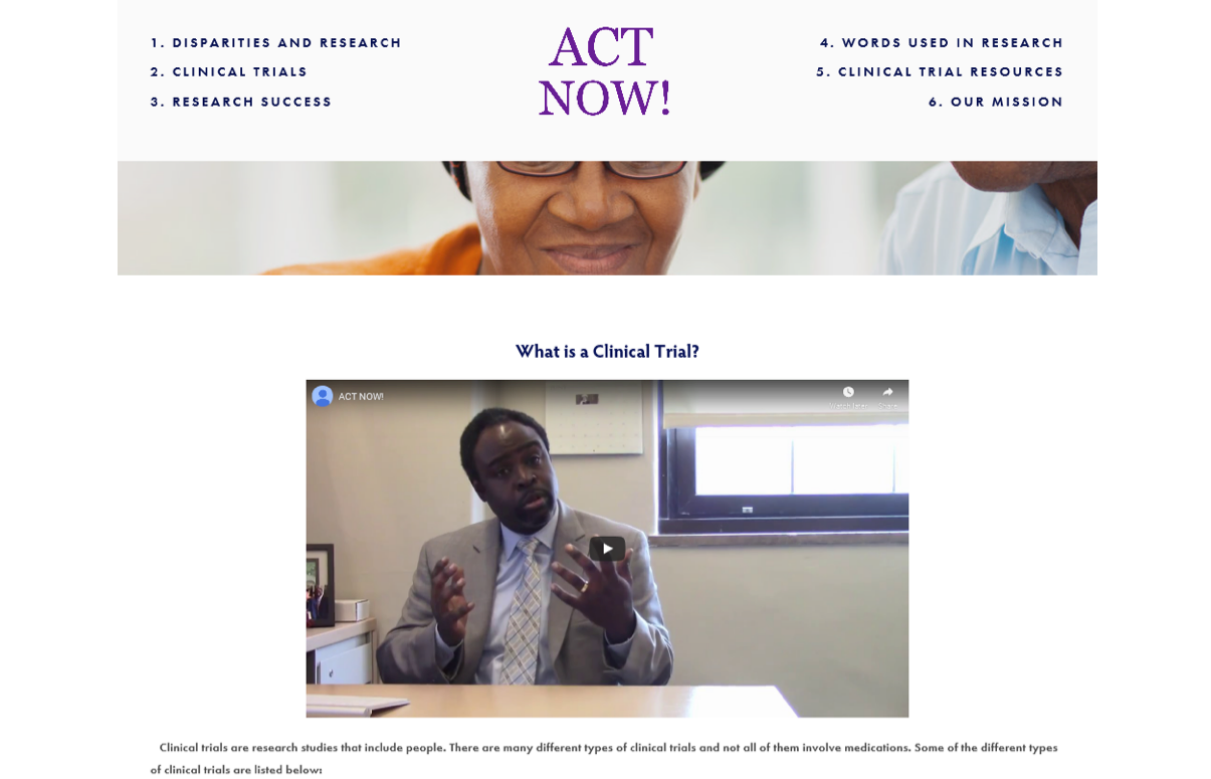
Figure 3. Joseph Ravenell, MD describing the different types of clinical trials, including community-based